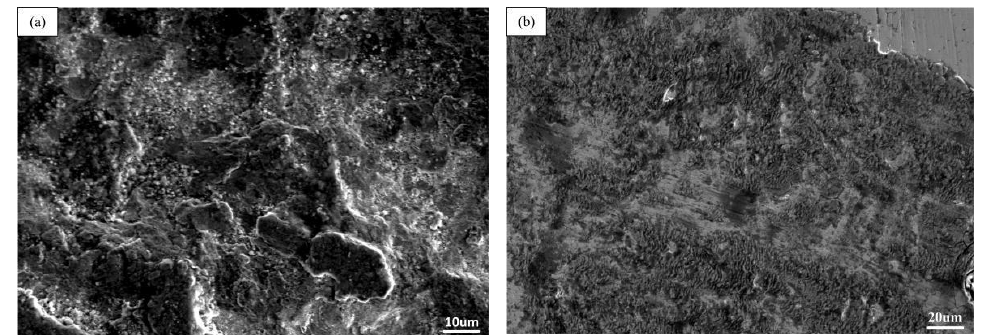
Figure 9. Wear morphology of Cu substrate and laser cladding: ( a ) wear morphology of the Cu substrate; ( b ) wear morphology of the cladding layer.